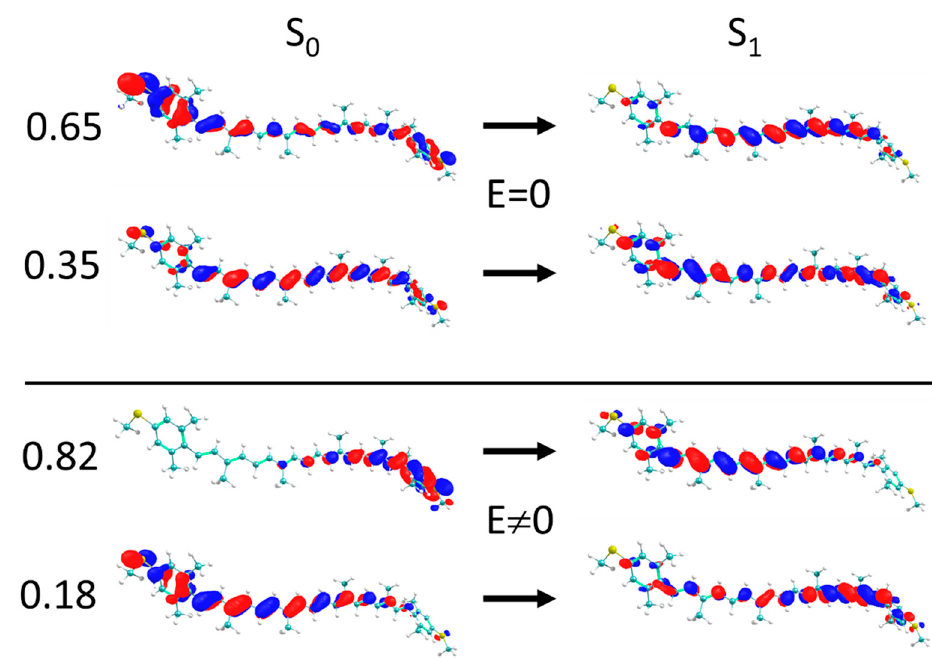
Figure 5. orbitals for the S 0 → S 1 natural transition of the trans-TMC in the absence (top) or pres- ence (bottom) of an EEF (0° dihedral angle). Left numerical column indicates the weight for each